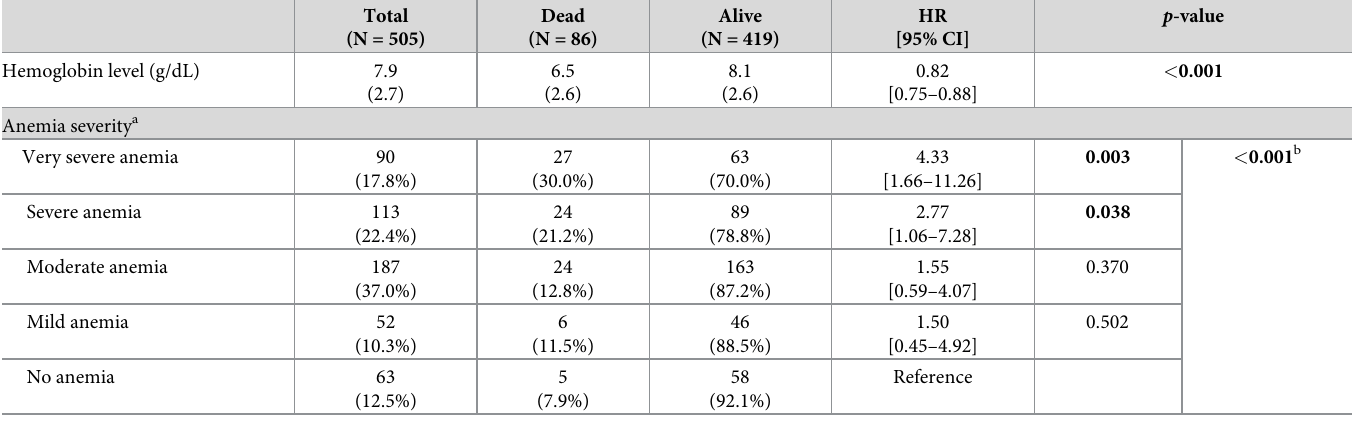
Table 2. Severity of anemia and overall mortality at 12 months for all study